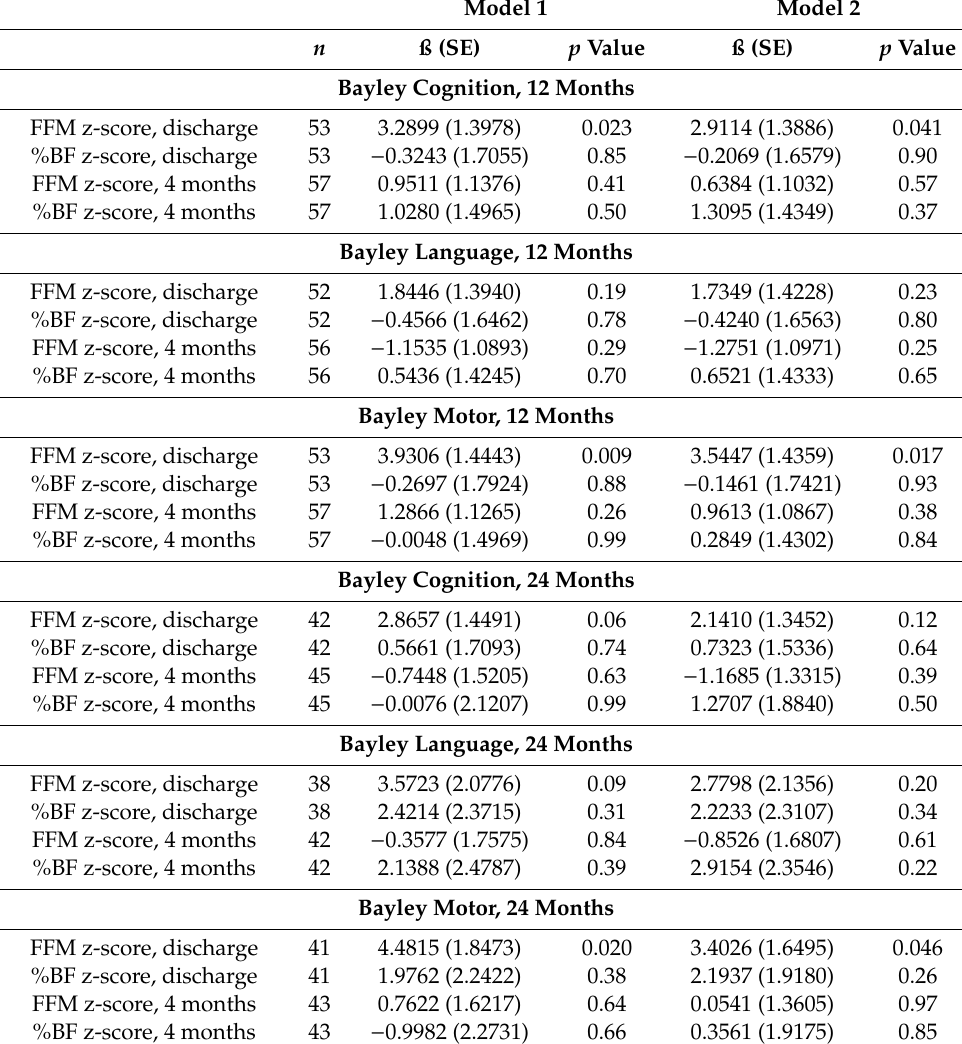
Table 4. Associations between Body composition z-scores and Neurodevelopmental outcomes (BSID scores at 12 and 24 months